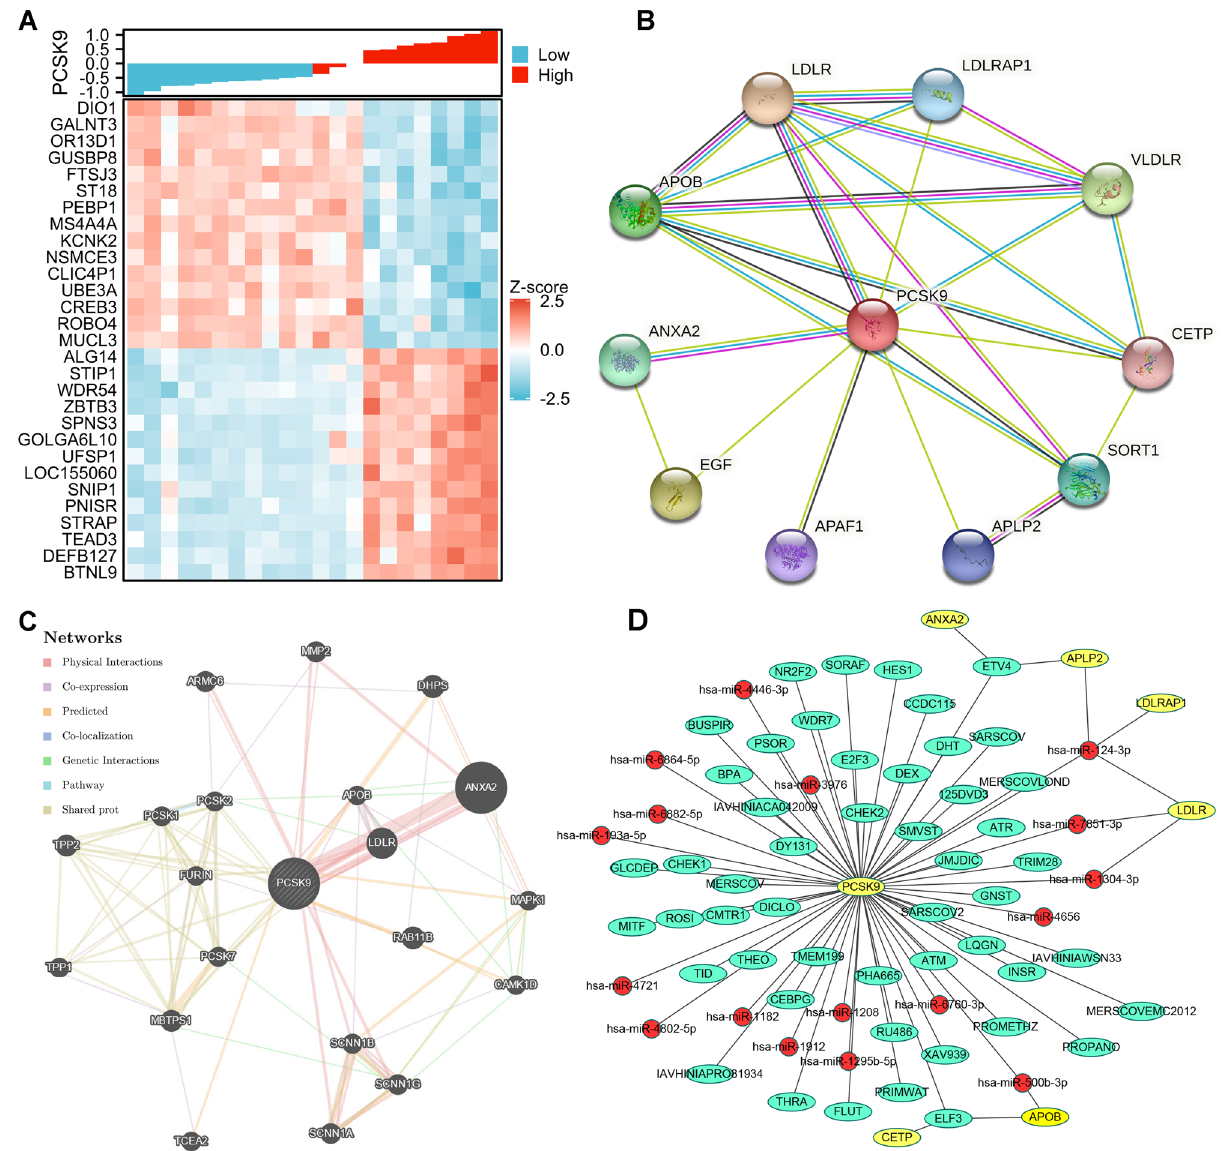
Figure 8. Potential protein, miRNA, and TFs regulating PCSK9. ( A ) Top 15 genes positive and negative correlated with PCSK9 in AAA neck. ( B ) The PPI network of PCSK9 in STRING database. The meaning of the color of the connecting lines can refer to the website (https:// www. string- db. org/). ( C ) The PPI network of PCSK9 in GeneMANIA database. ( D ) TF-target and miRNA-target network of PCSK9. Green: TFs; Red: miRNA; Yellow: protein that interacted with PCSK9 from PPI network; TFs: transcription